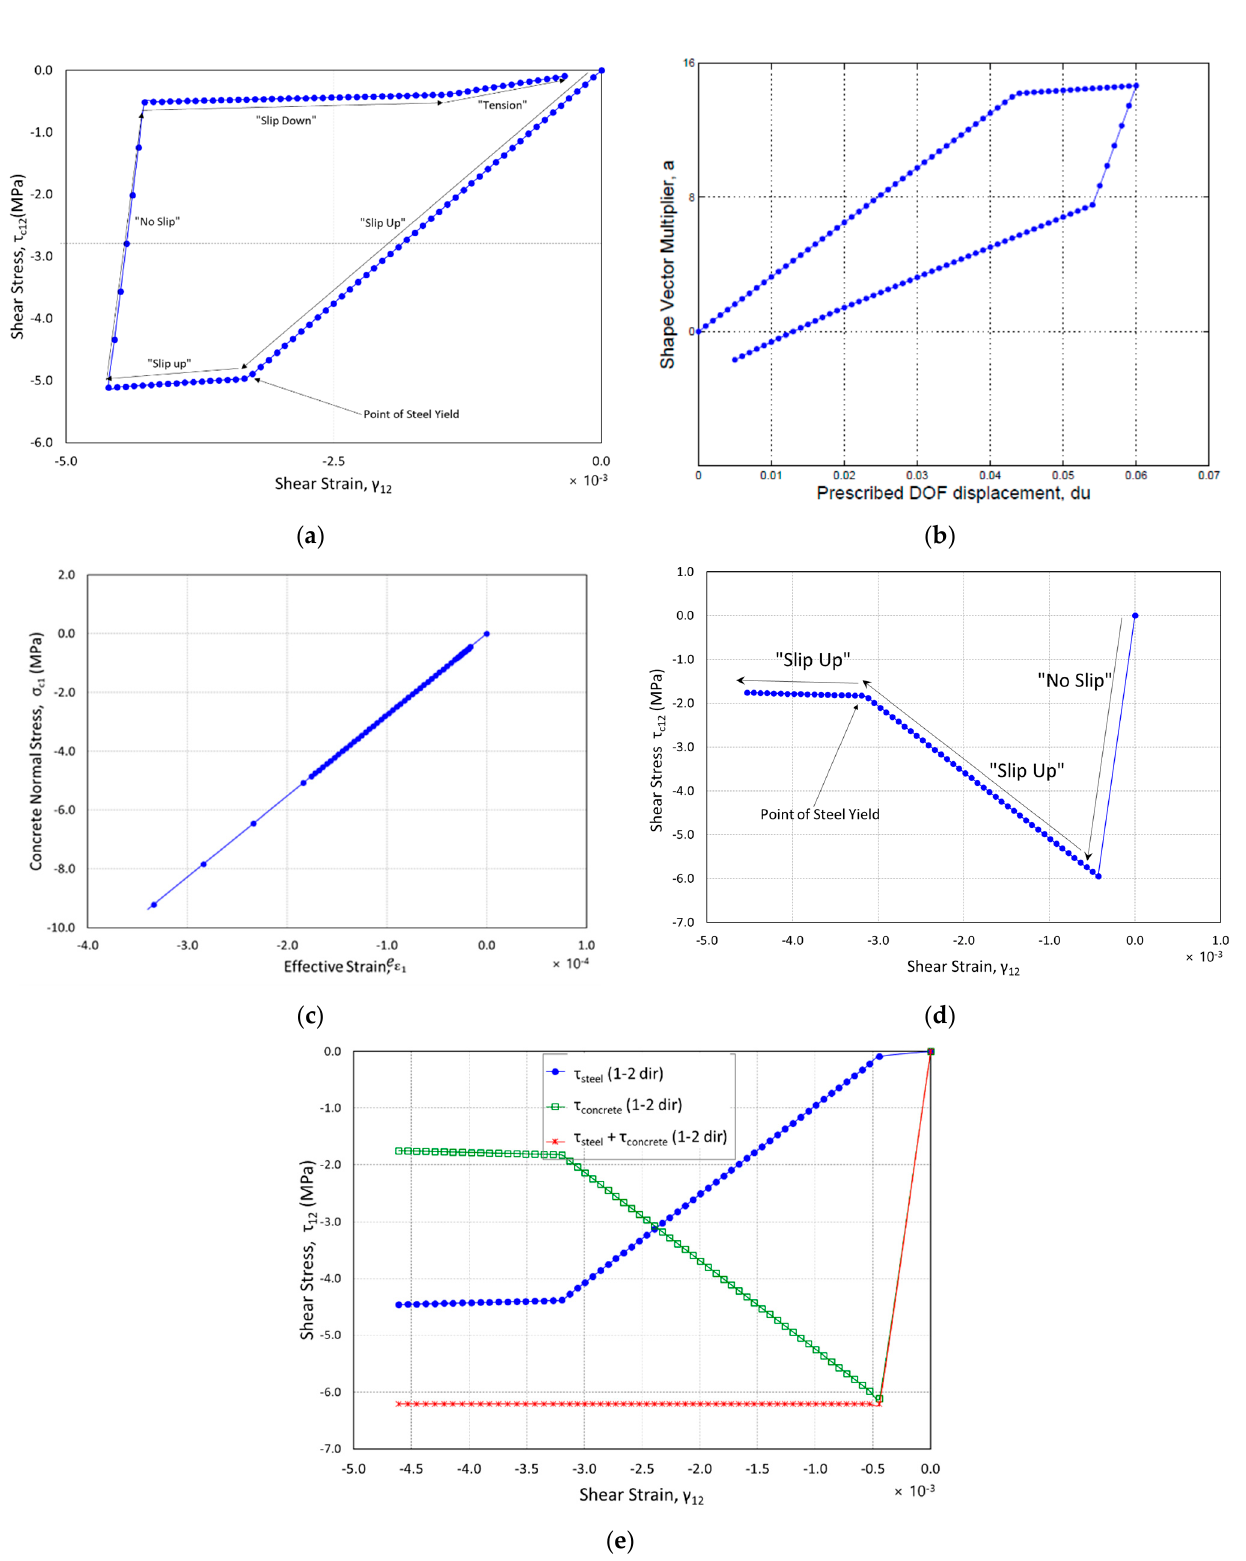
Figure 12. ( a ) Concrete shear stress (Crack 1) vs. shear strain (PLV); ( b ) shape vector multiplier vs. prescribed displacement (PLV); ( c ) concrete normal stress (Crack 1) vs. effective strain (CVL); ( d ) concrete shear stress (Crack 1) vs. shear strain (MNRM); ( e ) interaction between concrete and steel shearing stresses (MNRM).